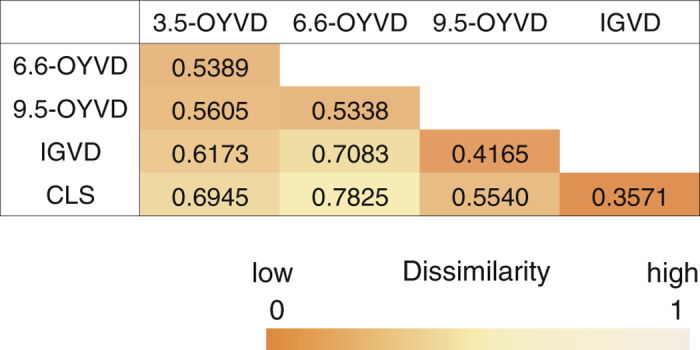
Colour-mapped matrix table of Bray−Curtis dissimilarity indices.Indices were calculated by using microbial abundance patterns of genus-assigned reads. The dissimilarity indices indicate that the lower number is more similar (i.e., not dissimilar) between samples. The colour indicator is shown in the figure.